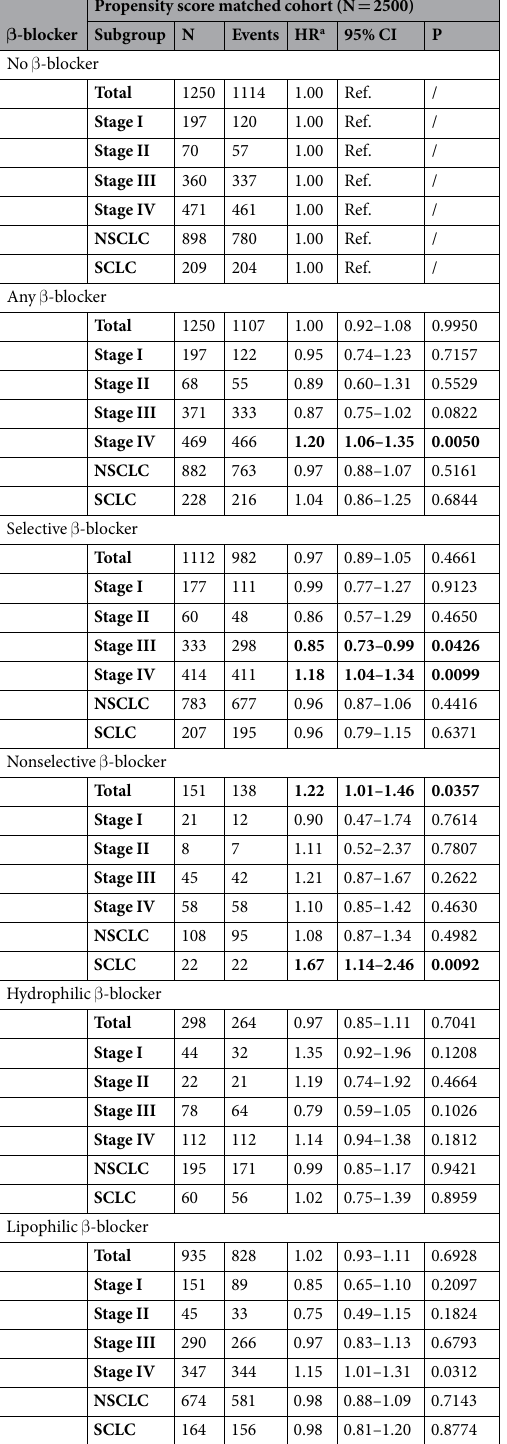
Table 2. Association between Pre-diagnostic β -blocker use and Lung Cancer Survival (Overall, by Cancer Site and Cancer Stage). Abbreviations: ATC = Anatomical Therapeutic Chemical Code, CI = Confidence interval, HR = Hazard ratio, NSCLC = Non-small cell lung cancer, PY = Person-years, SCLC = Small cell lung cancer a Hazard ratios from Cox proportional hazard regression on the propensity score matched groups for β -blocker use four months prior to diagnosis with additional adjustment for time-dependent use of Non-steroidal anti- inflammatory drugs, statins, antihypertensive (other than β -blocker) and diabetes medication after diagnosis. Stratification factors were omitted from the stratified